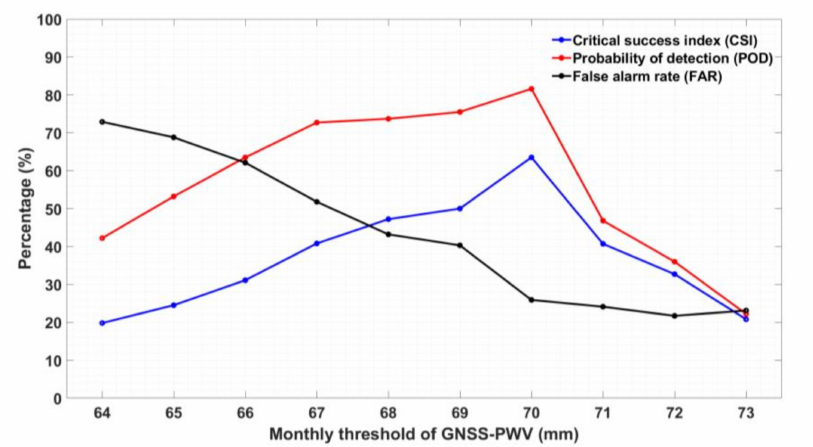
Figure 3. CSI (blue), POD (red) and FAR (black) scores from the last three columns in Table 4, the highest CSI score resulted from the candidate threshold value of 70.